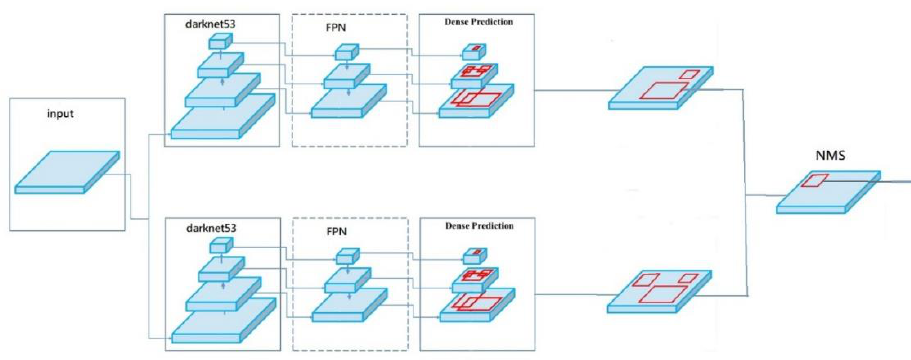
Figure 9. Classification model and object detection mode.